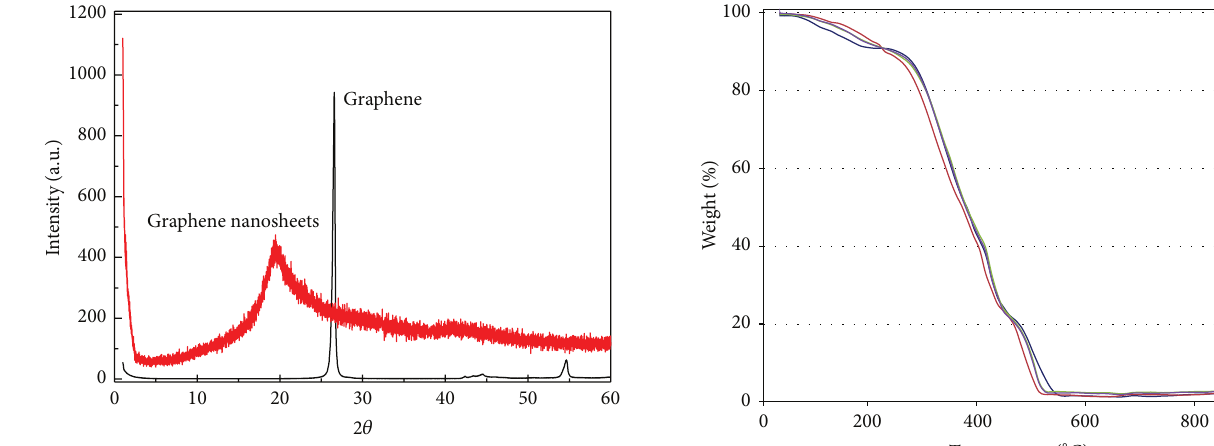
Figure 3: XRD spectra of the graphene and expanded graphene.